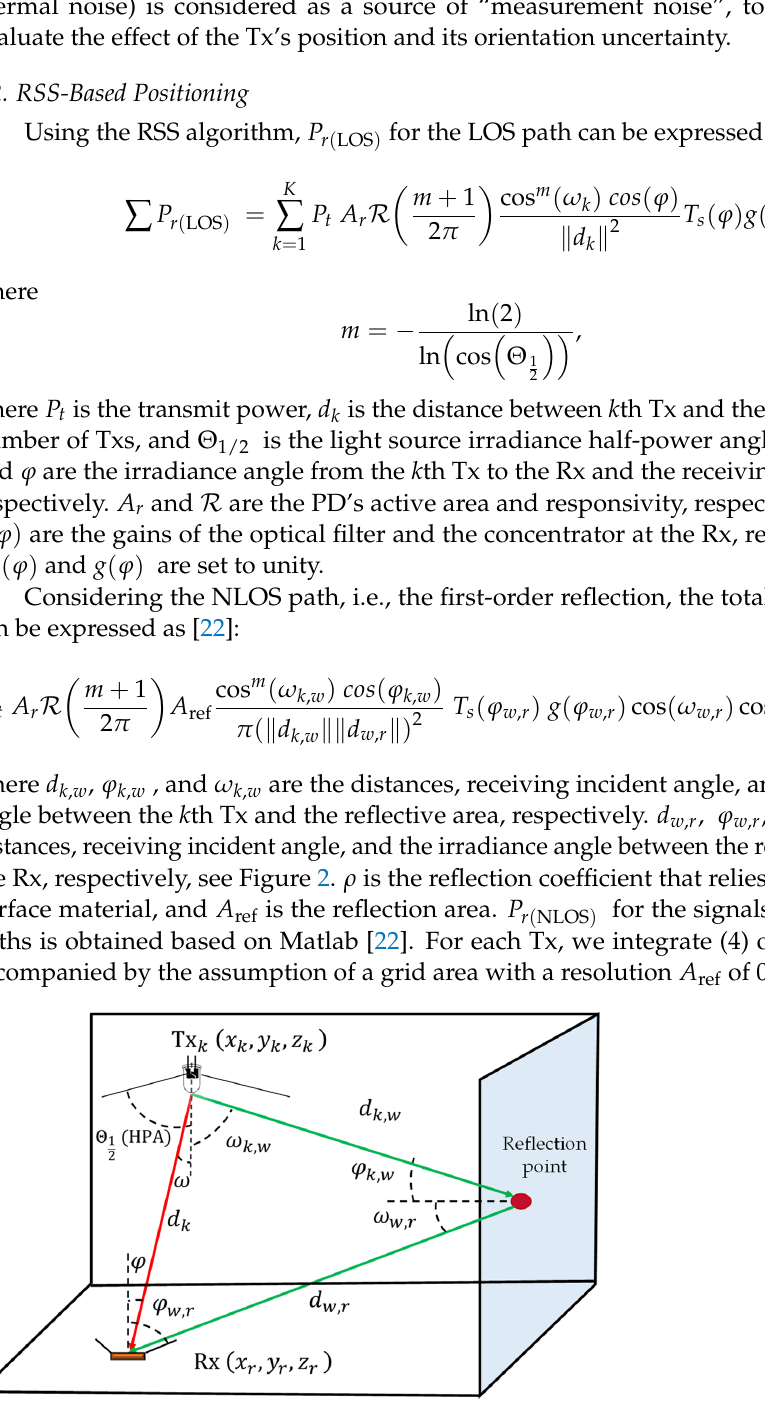
Figure 2. Overview of the visible light channel.